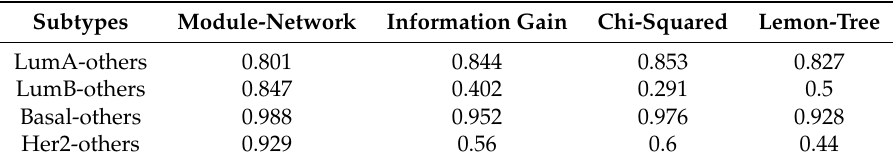
Table 2. The recall of 10-fold cross validation between subtypes.